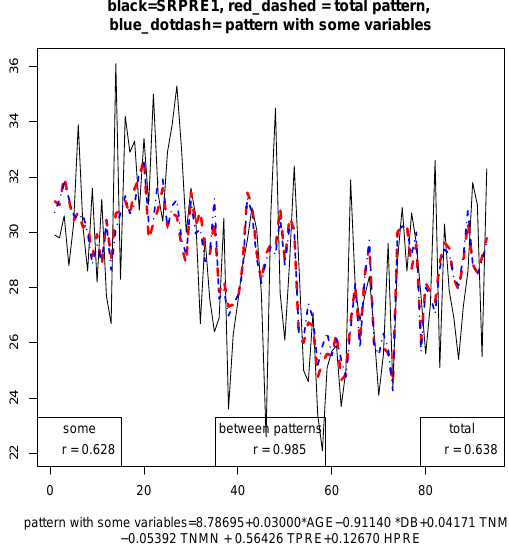
Figure 5. Pattern for the sole of the index 1, right foot before the